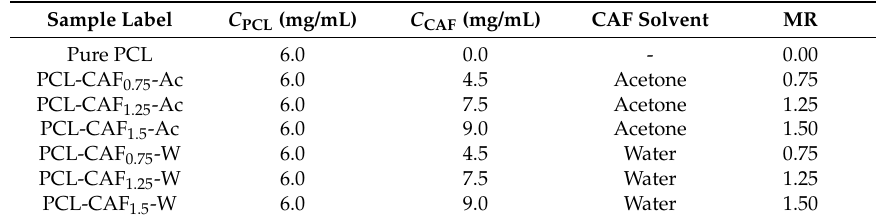
Table 2. PCL-caffeine nanoparticles formulations for which the zeta potential was